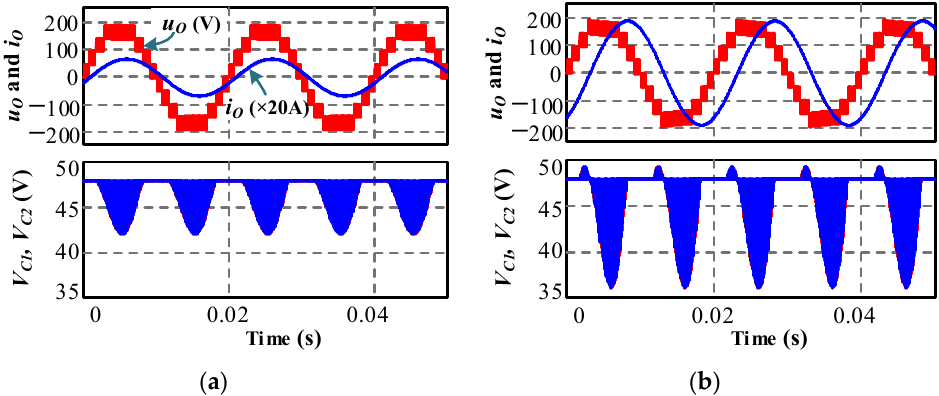
Figure 9. Simulation waveforms for the optimized inverter with inductive loads: ( a ) 50 Ω -50 mH; ( b ) 10 Ω -50 mH.